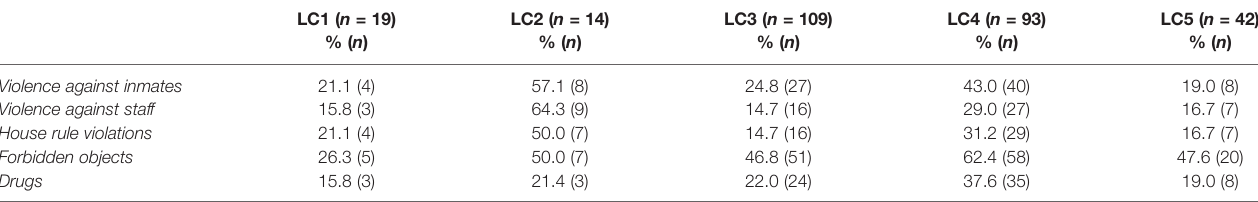
TABLE 5 | Types of prison misconduct by latent